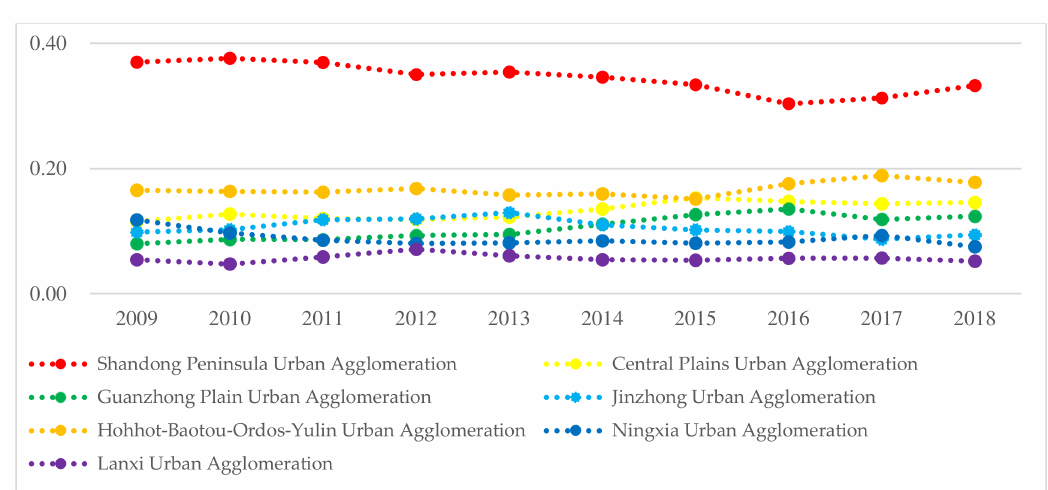
Figure 1. Research areas.